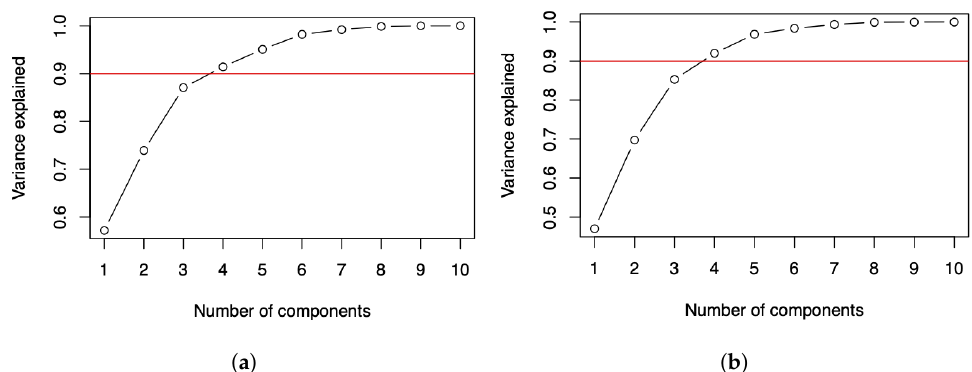
Figure 2. Cumulative variance plots of the number of COVID-19 ( a ) infected cases and ( b )